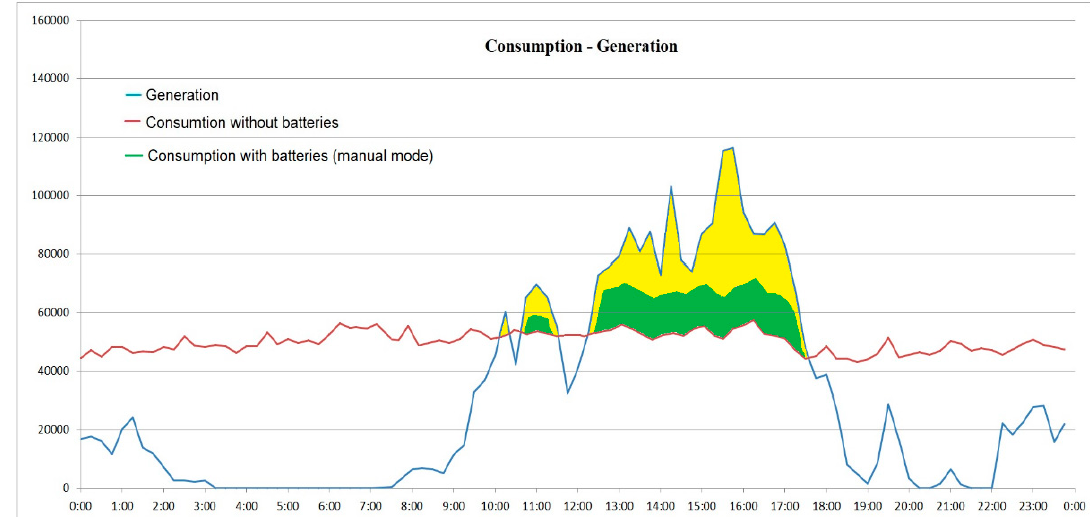
Figure 11. Daily grid generation–consumption graphic with batteries in manual mode (before im- plementation). Source: prepared by authors based on the results of this study.